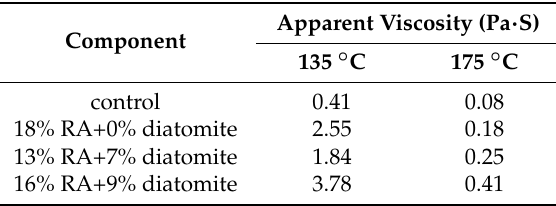
Table 5. The rotation viscosity test.